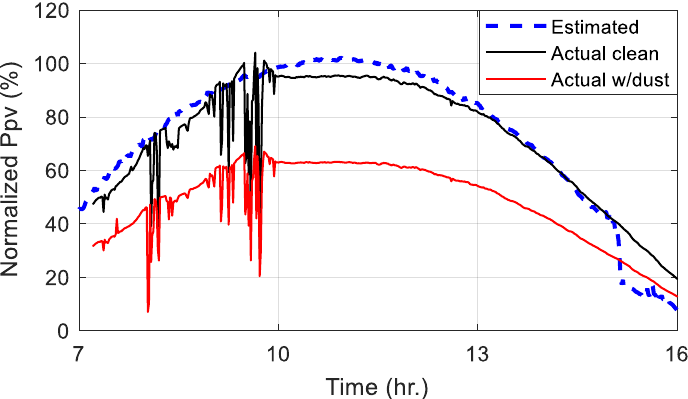
Figure 17. Estimated and actual PV output power during a partly cloudy day.